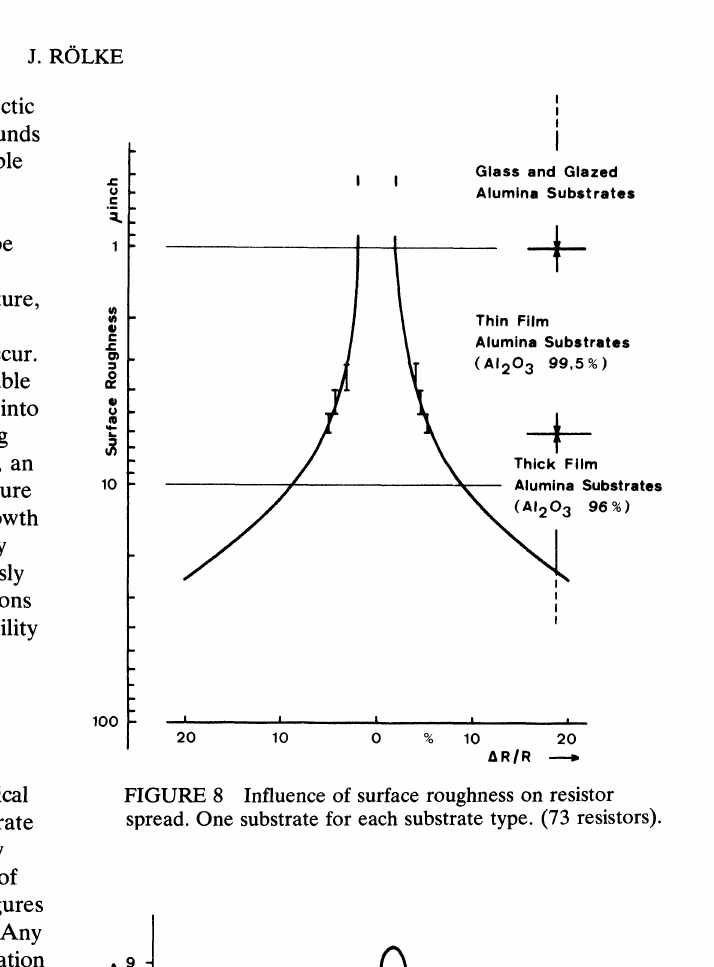
FIGURE 8 Influence of surface roughness on resistor spread. One substrate for each substrate type. (73 resistors).